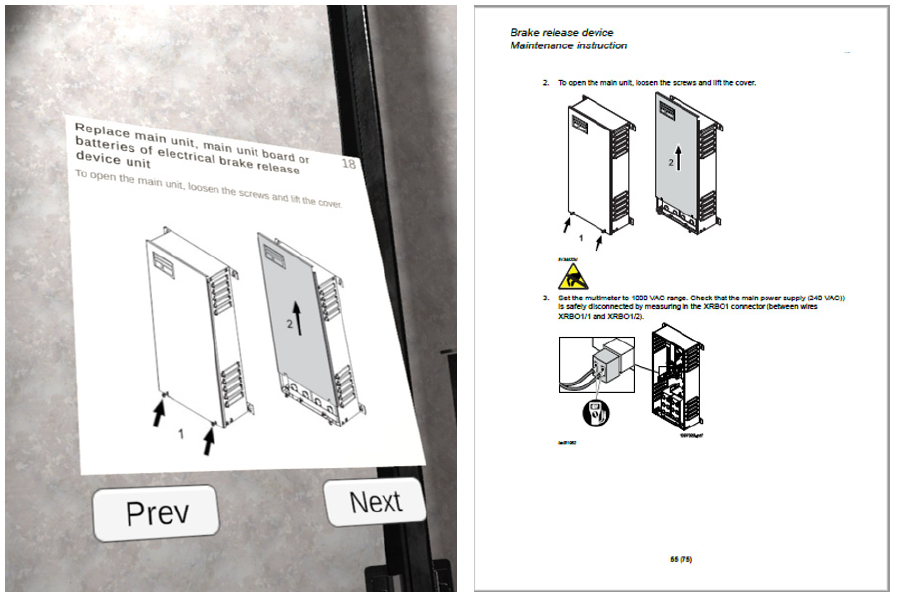
Figure 3. Task step visualized in the DocPanel Tool ( left ), the same step in the original PDF instruction ( right ).